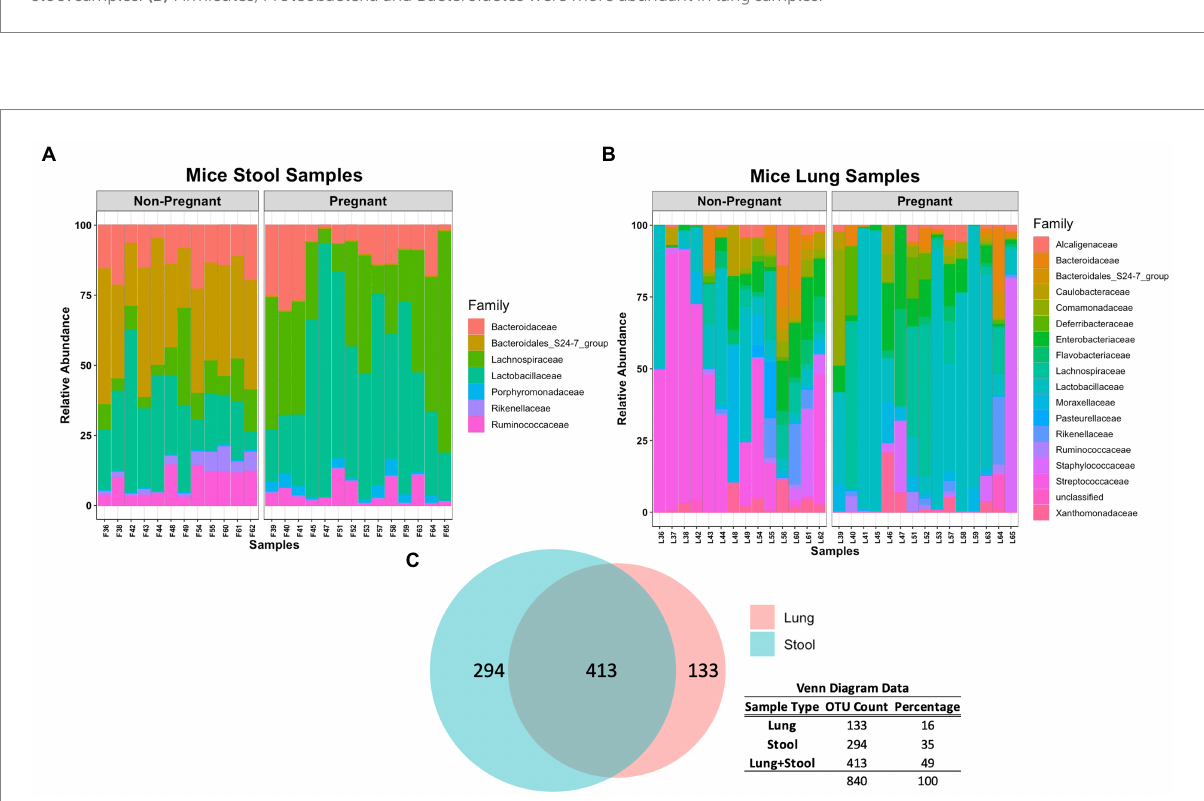
FIGURE 2 Comparing microbial composition at Family level of pregnant and non-pregnant stool and lung data. (A) Lachnospiraceae and Lactobacillaceae were more abundant in pregnant mice whereas Bacteroidales, Rikenellaceae and Ruminococcaceae were more abundant in non-pregnant mice stool samples. Similar to pregnant mice stool samples, Lactobacillaceae are more abundant in pregnant mice lung samples. (B) Lactobacillaceae was more abundant in pregnant mice whereas Streptococcaceae was more abundant in non-pregnant mice lung samples. (C) Venn diagram demonstrates that lung and stool data share about 413 OTUs in common, while 133 OTUs are unique to the lung data and 294 OTUs are unique to the stool